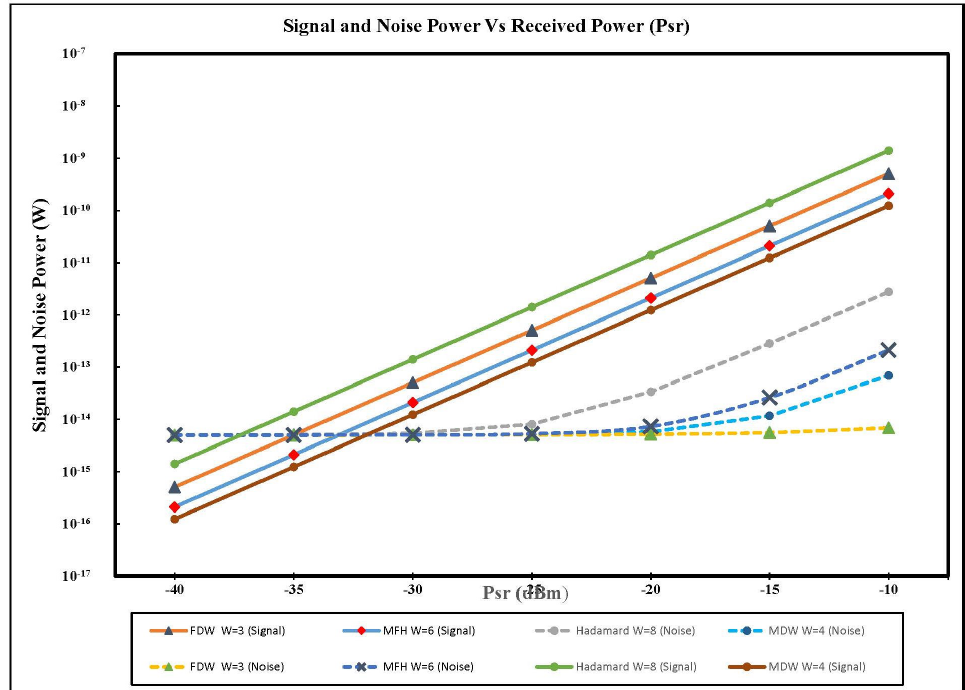
Figure 4. Performance of OCDMA code signal and noise power (W) versus received power, Psr